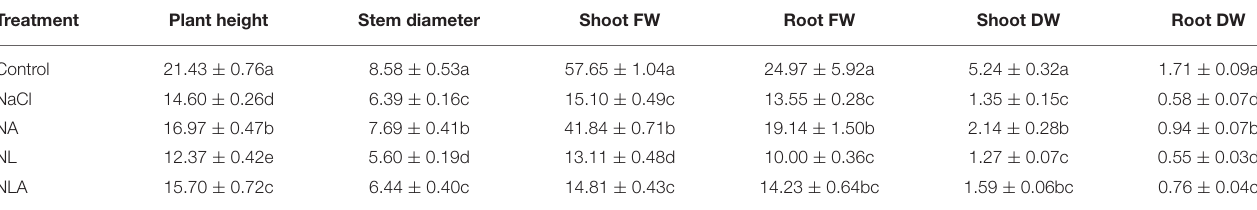
Different letters (a, b, c, d, and e) indicate significant difference at P < 0.05 among treatments. Note: Control, no added NaCl, no sprayed AsA and LYC; NaCl, added 100 mmol/L NaCl; NA, added 100 mmol/L NaCl and sprayed 0.5 mmol/L AsA; NL, added 100 mmol/L NaCl and sprayed 0.25 mmol/L LYC; NLA, added 100 mmol/L NaCl and sprayed 0.25 mmol/L LYC and 0.5 mmol/L AsA.